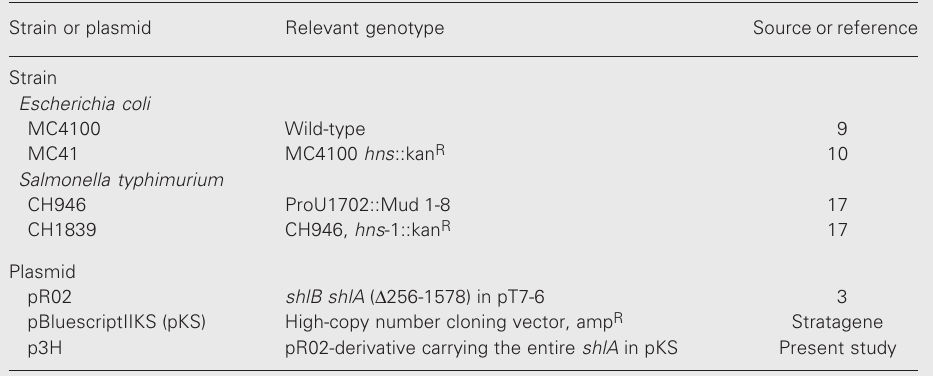
Table 1. Bacterial strains and plasmids used in the present